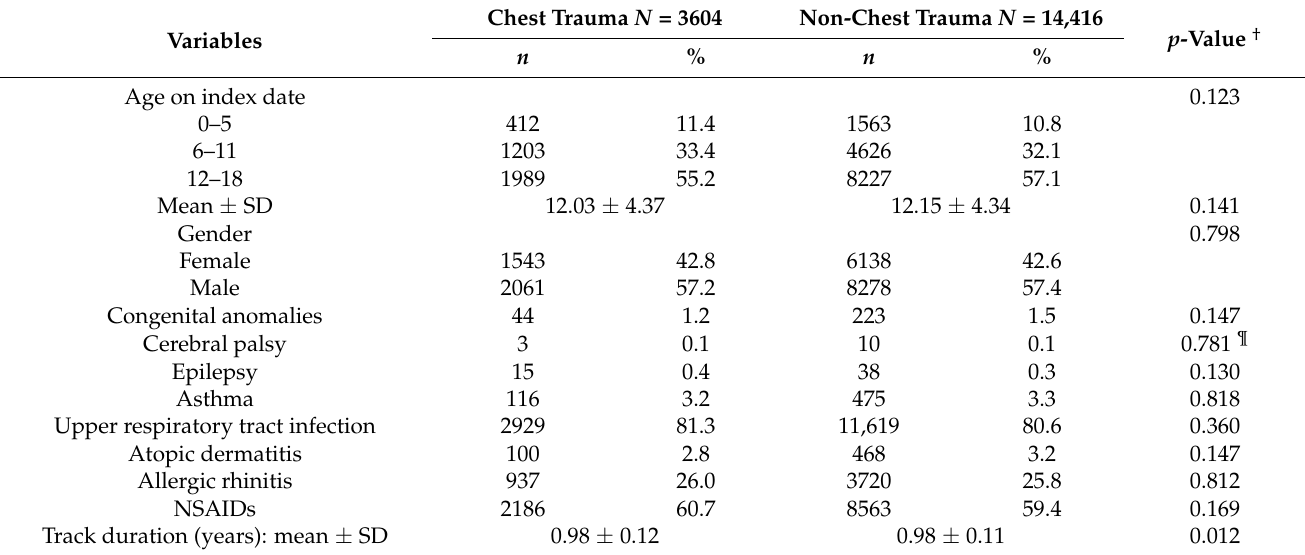
Table 1. Demographic data of study population of chest trauma and non-chest